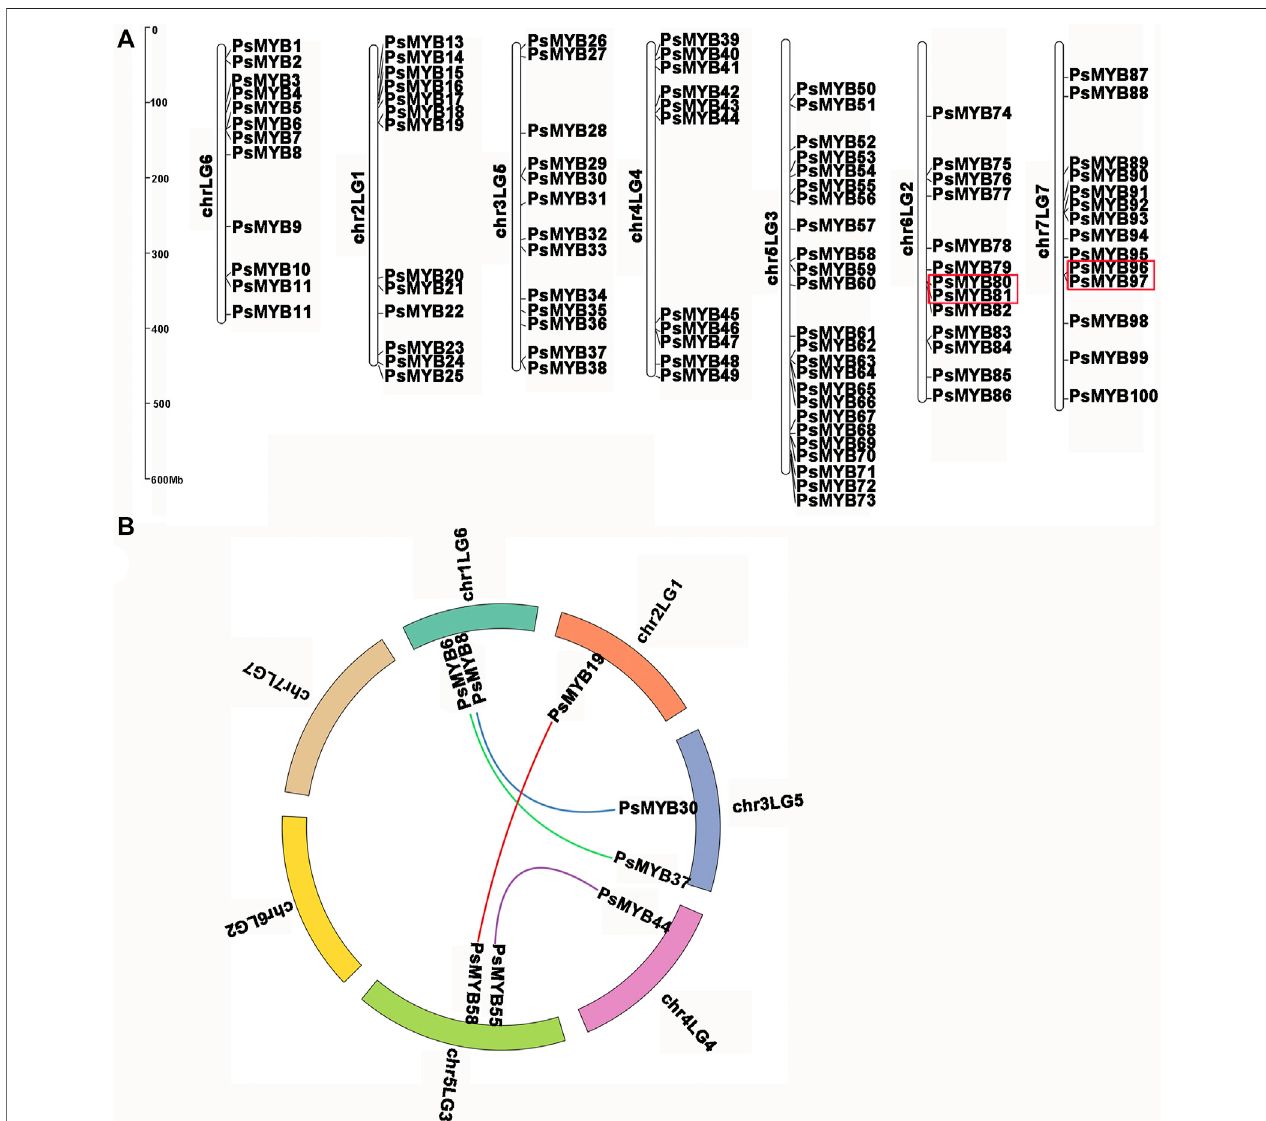
FIGURE 4 | Chromosomal locations and gene duplication of pea R2R3-MYB . (A) The chromosomal position of each R2R3-PsMYB was mapped into the P . sativum genome. The chromosome number is indicated at the left of each chromosome. The scale is in mega bases (Mb). The tandemly duplicated genes are indicated by red box. (B) The segmentally duplicated genes are marked in different color curve